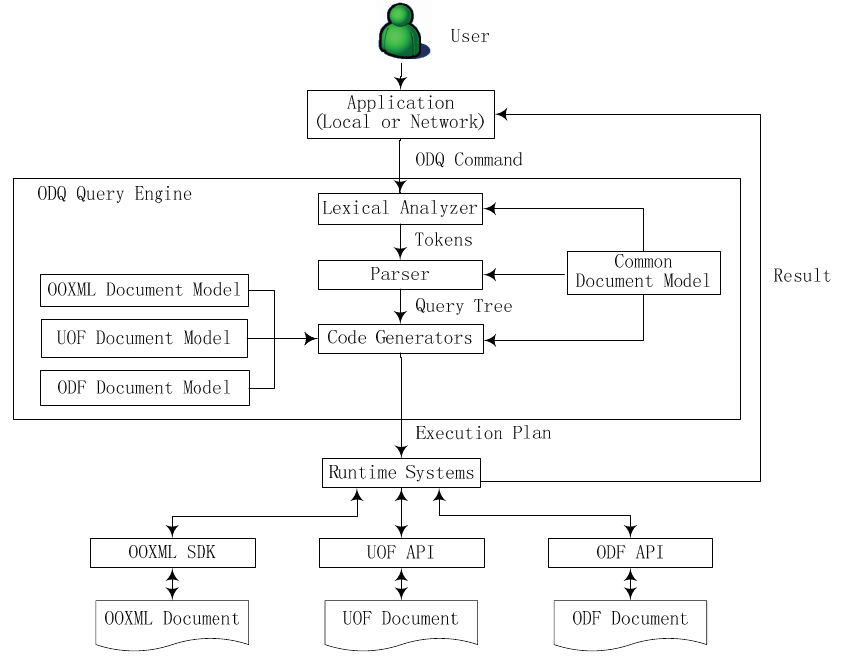
Figure3. Application framework integrated with